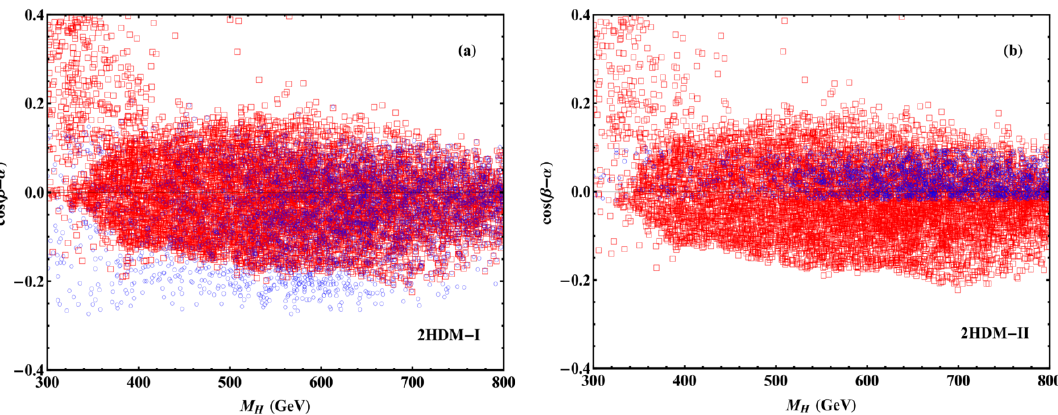
Figure 4 . Current experimental constraints on the 2HDM parameter space in the M plane for 2HDM-I in plot-(a) and for 2HDM-II in plot-(b). The blue points (circle shape) satisfy